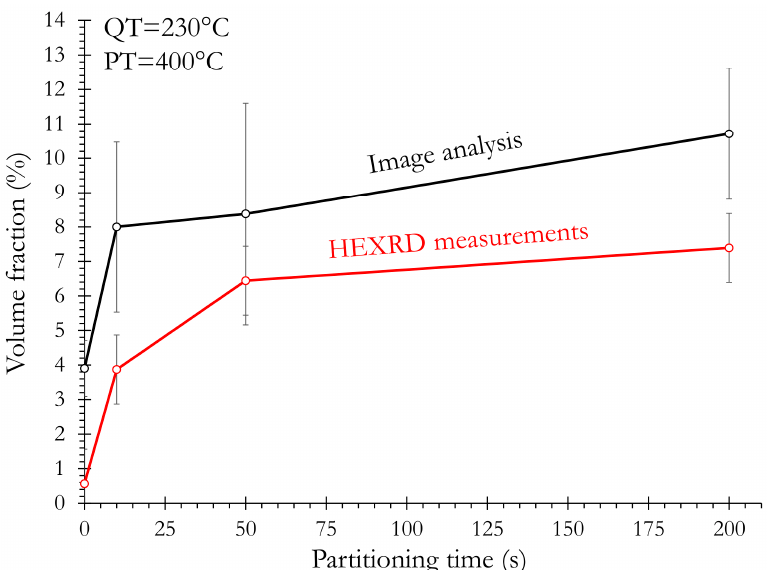
Figure 10. Comparison of the evolution of the bainite fraction measured by image analysis (black curve) and the new BCT phase measured by high-energy X-ray di ff raction (HEXRD) (red curve) (QT = 230 ◦ C PT / t = 400 ◦